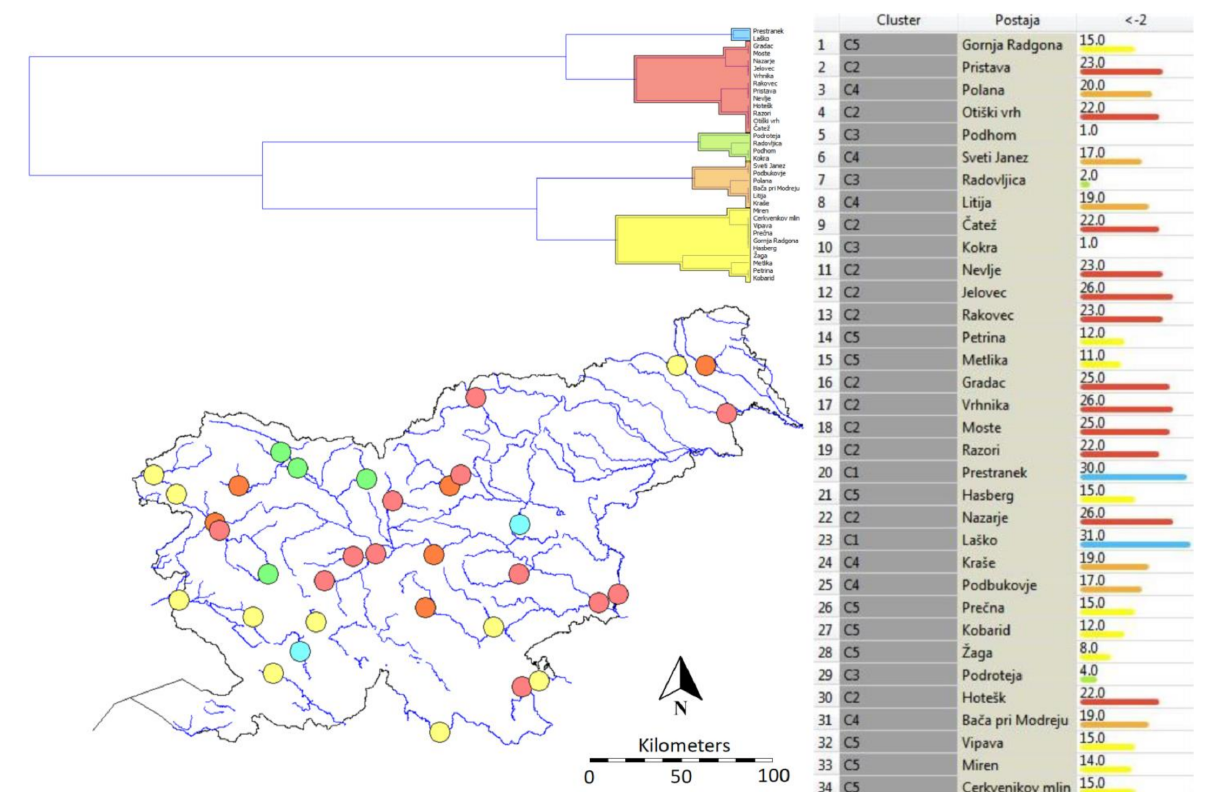
Figure 8. Hierarchical clustering of the number of extreme droughts using the 12 month time scale (SSI-12 < − 2) and spatial presentation of the results on the map of Slovenia. Groups are indicated by colours: C1 (blue), C2 (red), C3 (green), C4 (orange), and C5